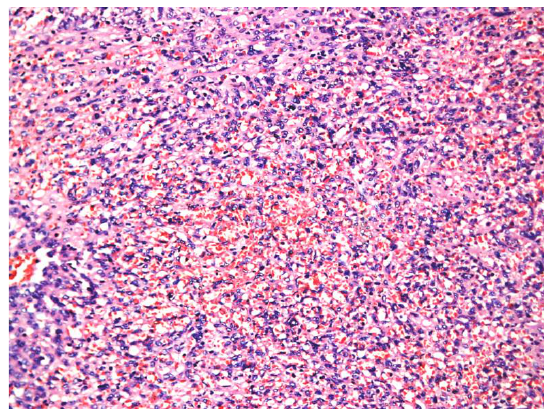
Figure 1 - The splenic tumour showing numerous complex capillary size